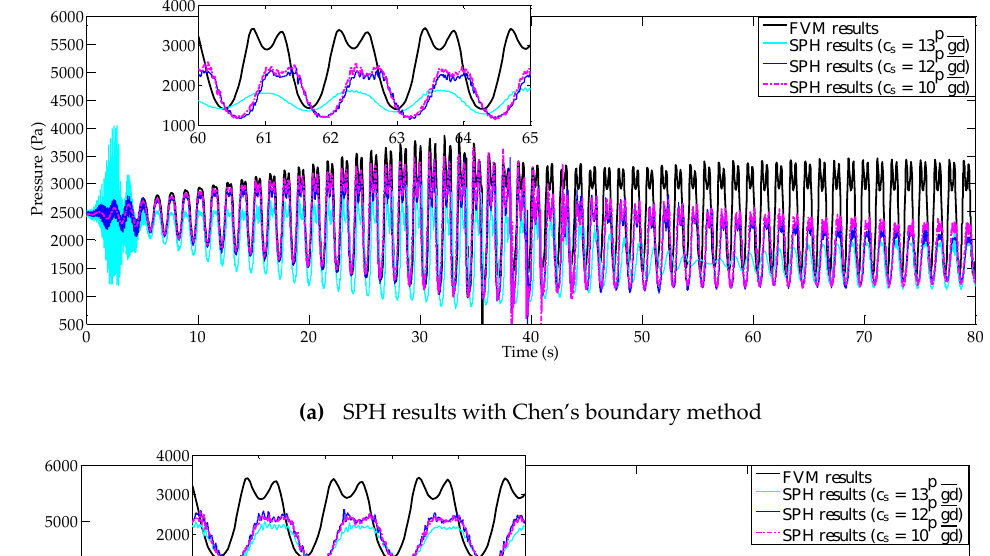
FVM results SPH results (c s = SPH results (c s =